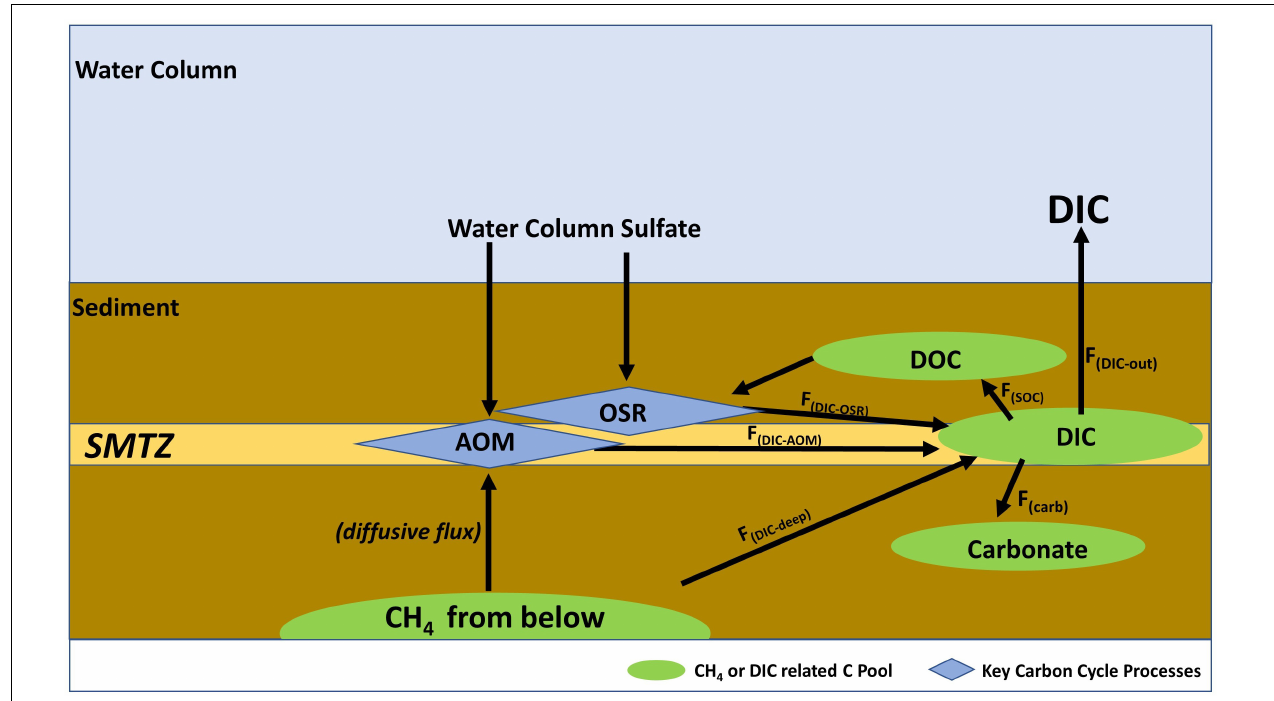
FIGURE 1 | A simplified representation of DIC cycling at diffusion-controlled marine settings. Figure 4 provides DIC flux estimates. Refer to section “Calculations” for descriptions of flux parameters.